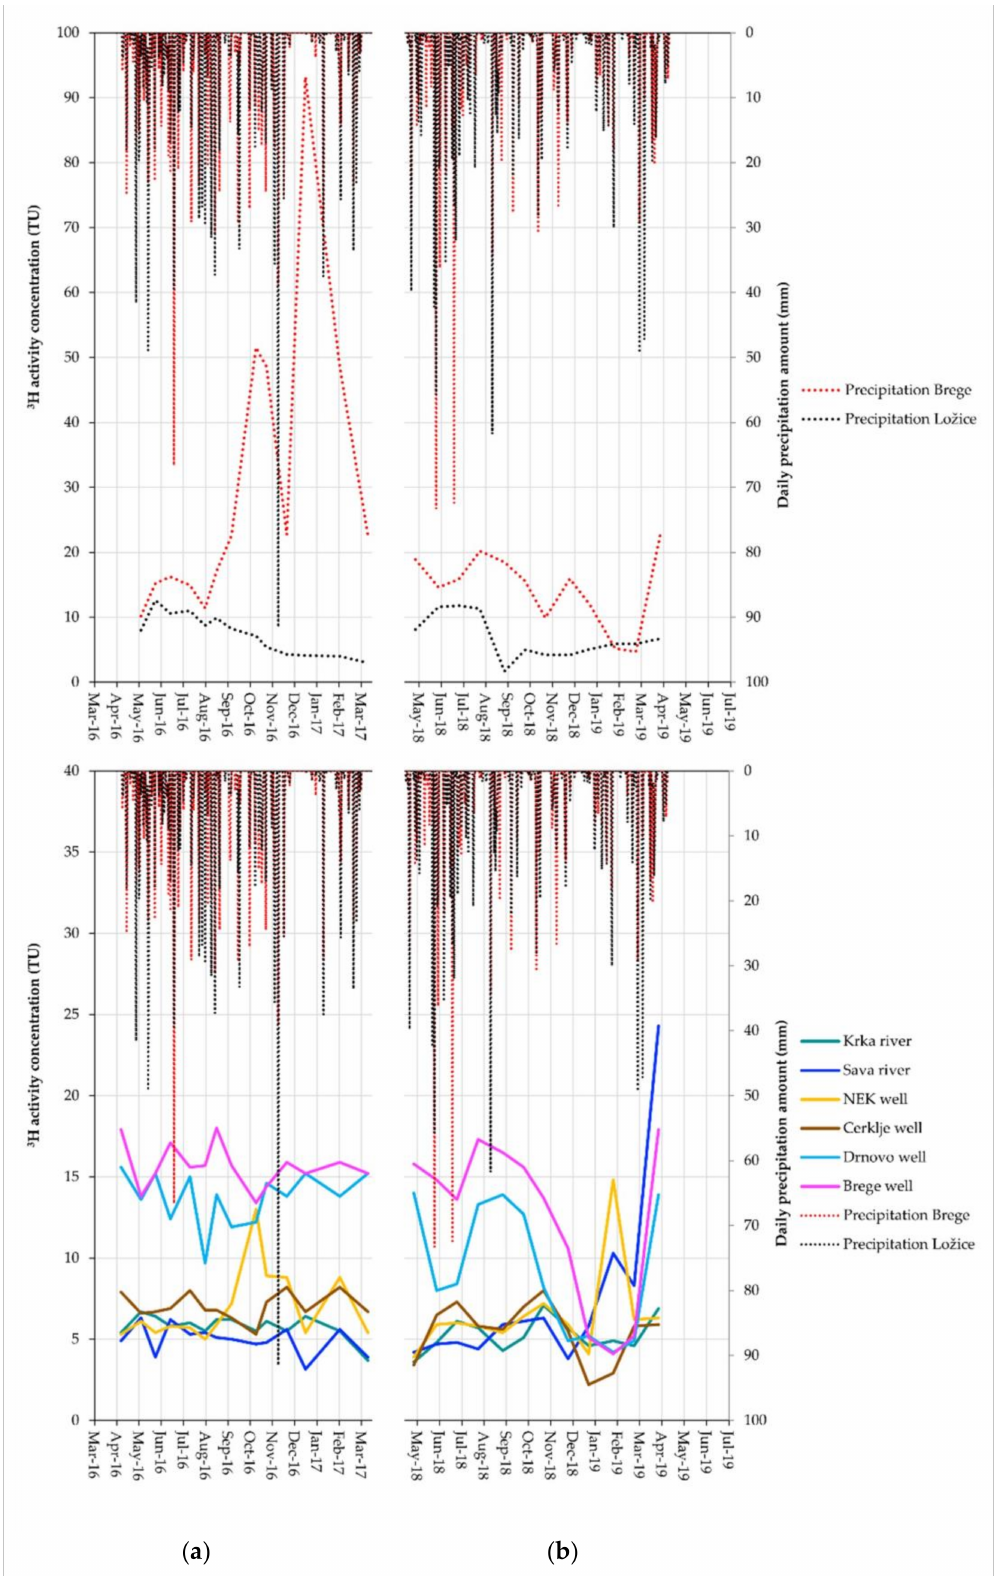
Figure 8. Oscillation of concentrations of tritium activity in water samples ( a ) before and ( b ) after the filling of the accumulation basin for the HPP Brežice in relation to the daily amount of precipitation in Brege and Puste